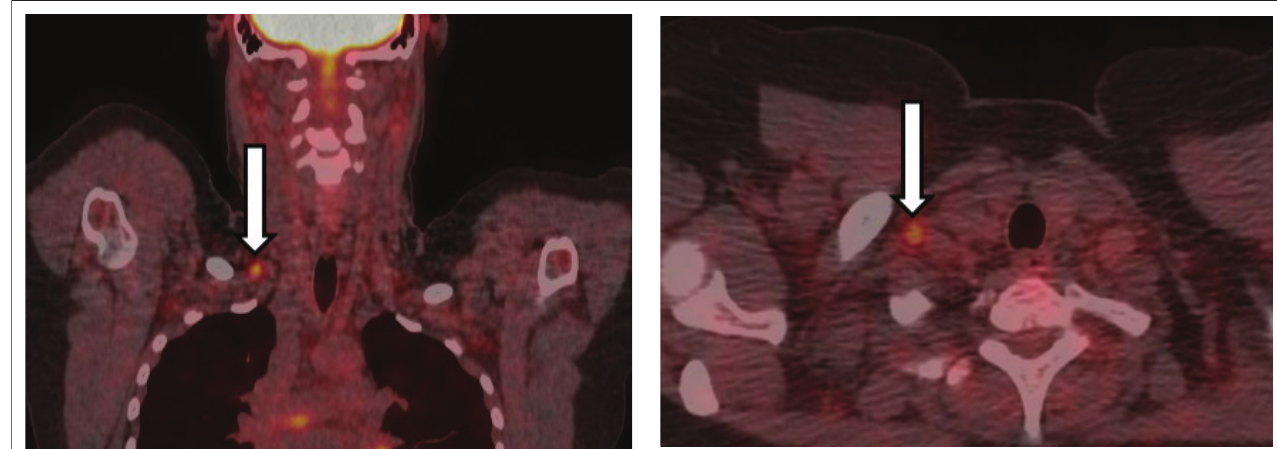
FIGURE 2: A 32-year-old with triple negative breast cancer with suspicious right supraclavicular node on fluorodeoxyglucose positron emission tomography/computed tomography. SUVmax primary tumour = 24.7, suspected metastatic supraclavicular node = 3.5. Biopsy results were negative for